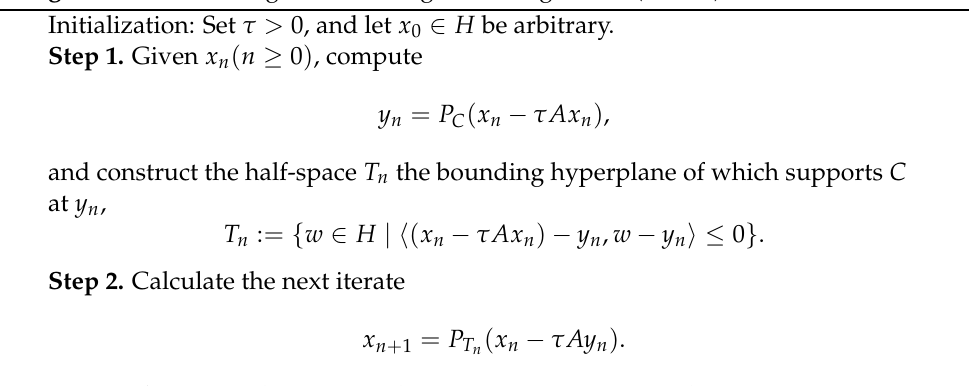
Algorithm 1: The subgradient extragradient algorithm (SEGM).